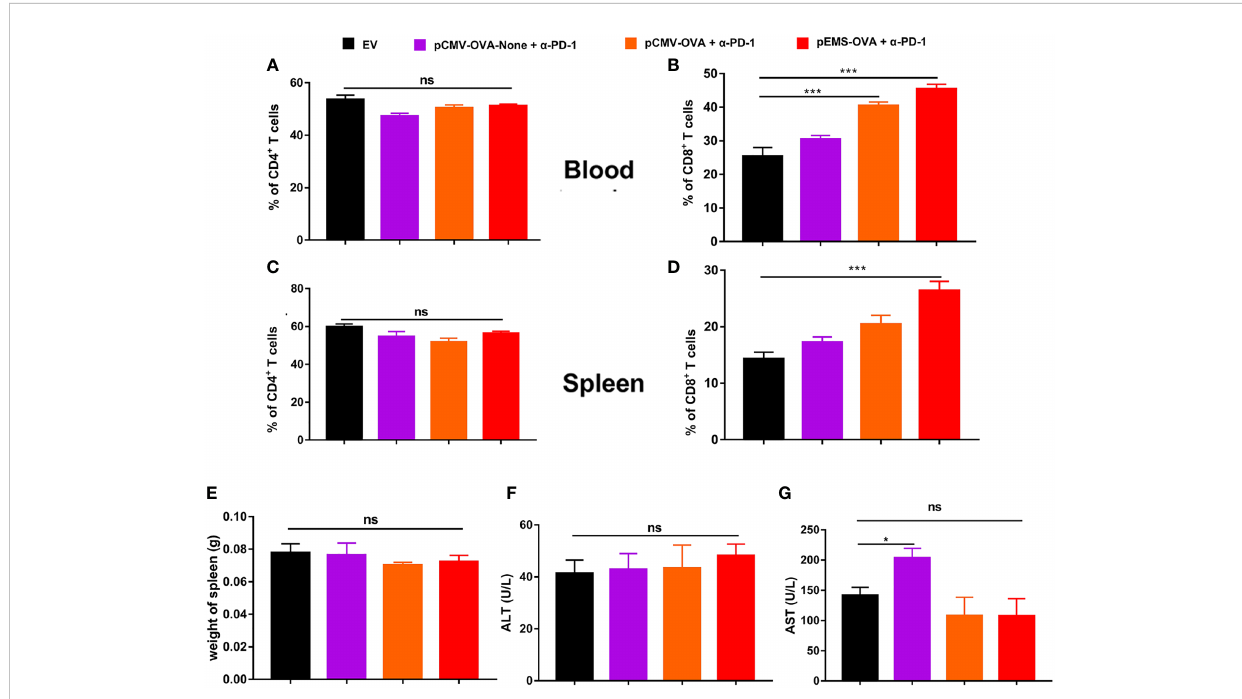
FIGURE 6 Immune cell populations and biochemical analysis of combination DNA vaccination and intramuscular gene transfer of PD-1 antibody in B16F10- OVA model. All mice were sacri fi ced at day 29. Immune cell populations analysis of spleen and blood from mice receiving four different treatments. (A) Percentage of CD4 + T cells in the blood. (B) Percentage of CD8 + T cells in the blood. (C) Percentage of CD4 + T cells in the spleen. (D) Percentage of CD8 + T cells in the spleen. (E) Spleen weight. (F) ALT level in the serum of mice. (G) AST level. Data are shown as means ± SDs. Statistical analyses were performed using one-way ANOVA with Dunnett ’ s multiple comparison test. *p < 0.05; **p < 0.01; ***p < 0.001. ANOVA, analysis of variance; AST, aminotransferase; ALT, alanine aminotransferase. .